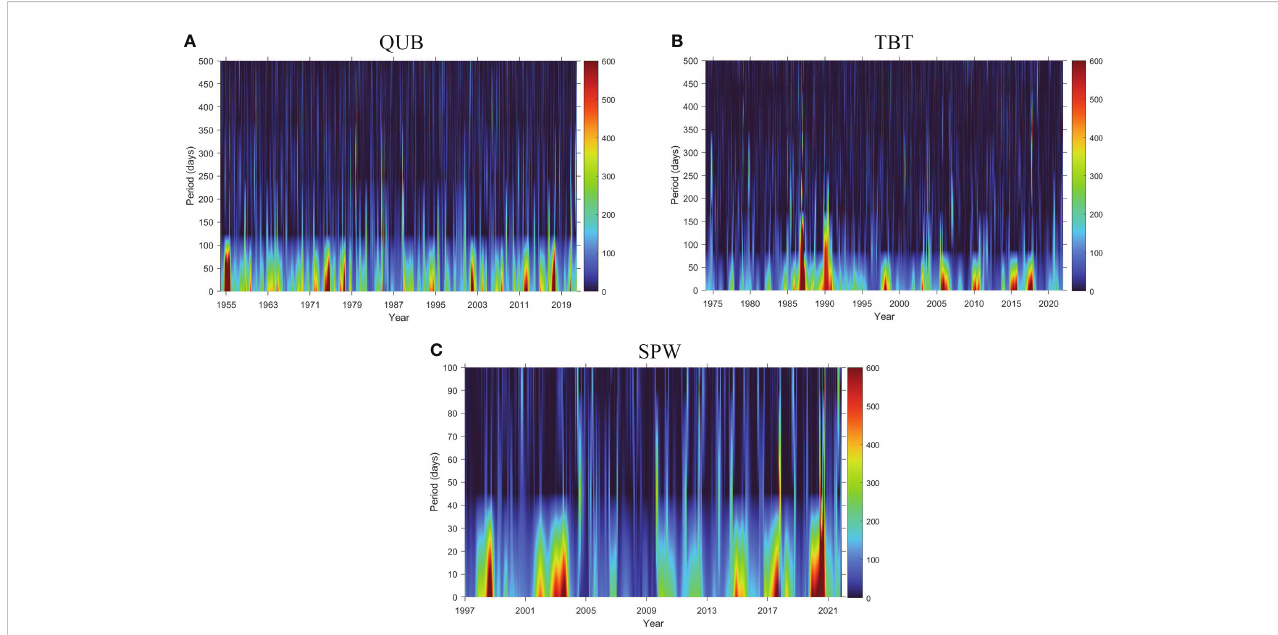
FIGURE 7 The Hilbert spectrum of three tide gauge stations. X axis represents the years. Y axis represents period. Color bar present the intensity of tidal amplitude. Red represents large tidal amplitude, while blue represents small tidal amplitude. (A – C) are the QUB, TBT, and SPW tide gauge stations, respectively.